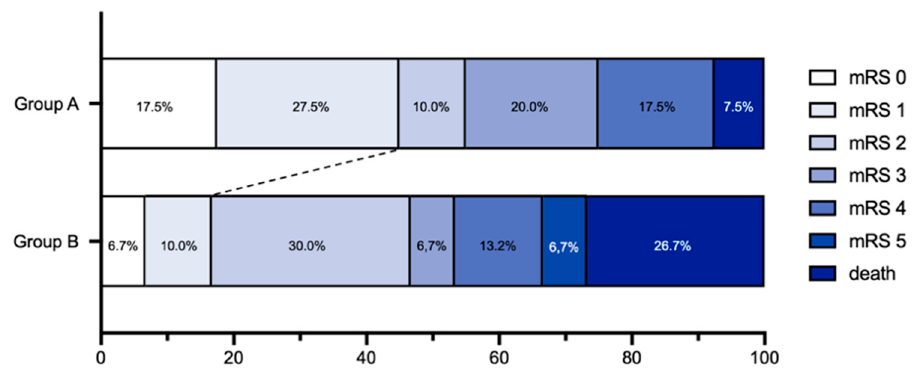
Figure 3. The modified Rankin Scale (mRS) score at 90 days demonstrates a shift toward excellent outcome (mRS 0–1) for patients in group A ( n = 40) as compared with group B ( n =